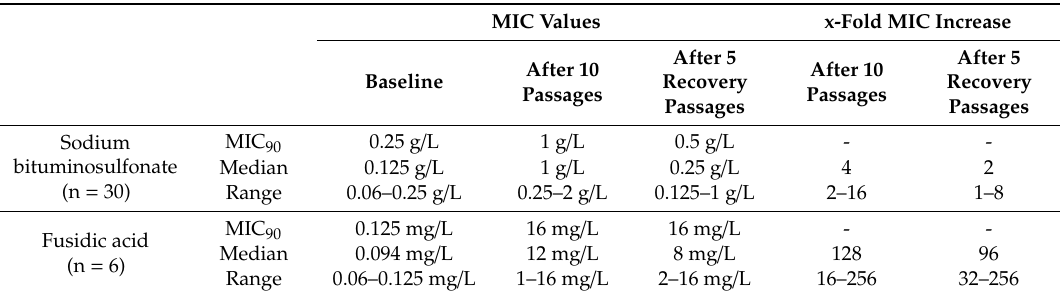
Table 1. Minimal inhibitory concentration (MIC) values and corresponding x-fold MIC increases for sodium bituminosulfonate and fusidic acid prior (baseline) and after 10 passages on agar plates containing the active agent as well as after five recovery passages on plain plates.